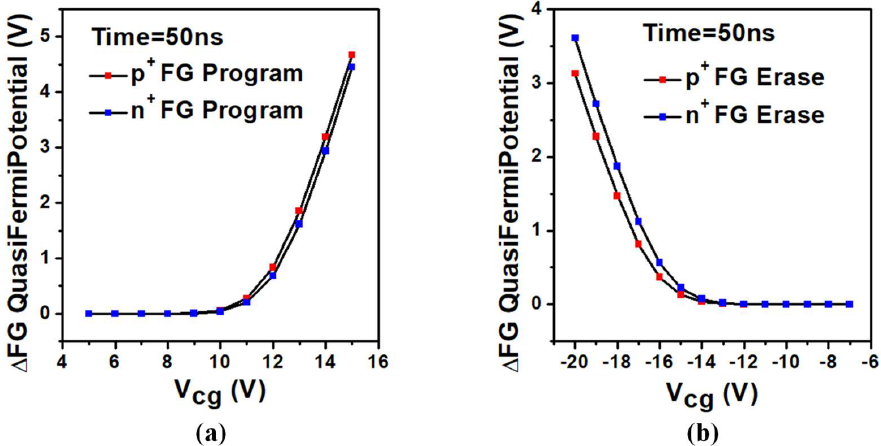
Figure 3. FG potential shift in UFGM as a function of V CG after ( a ) 50 ns programming operation and ( b ) 50 ns erasing operation. The other contacts are set to 0 V.